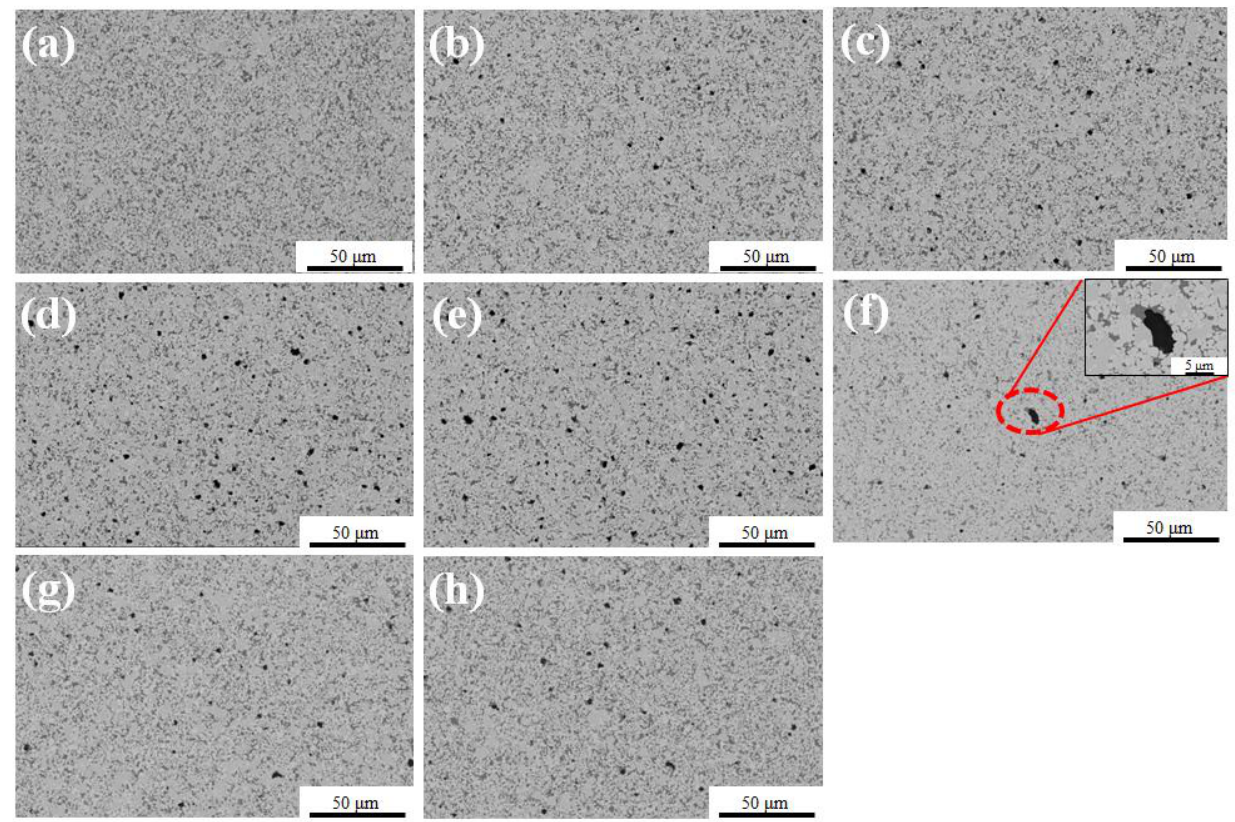
Figure 11. BSE-SEM microstructure of different composites, ( a ) 0Fe-5.3C, ( b ) 1Fe-5.3C, ( c ) 2Fe-5.3C, ( d ) 3Fe-5.3C, ( e ) 4Fe-5.3C, ( f ) 2Fe-5.1C, ( g ) 2Fe-5.5C, ( h ) 2Fe-6.3C.